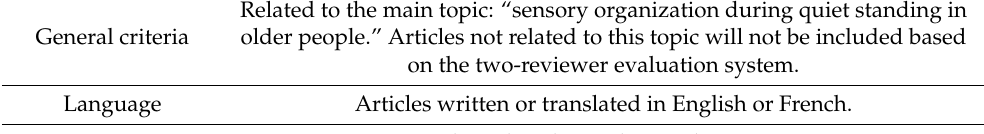
Table 2. Inclusion